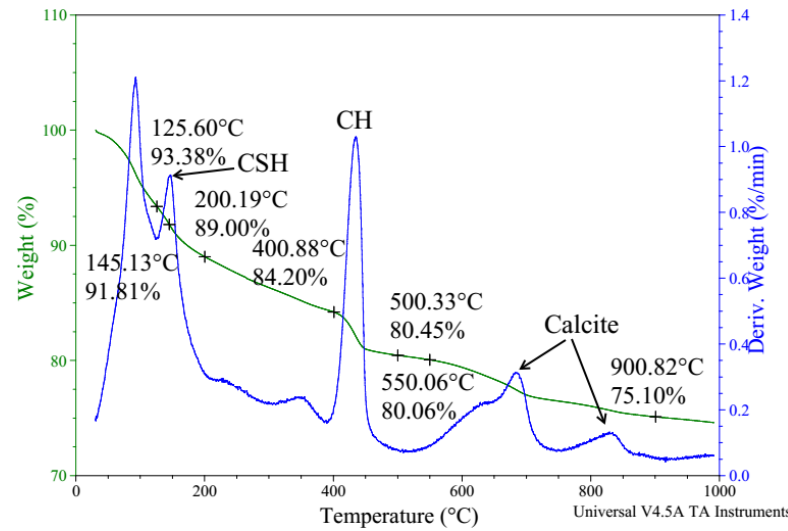
Figure 17. TGA/DTG observations of TEOS/PVP NFs-blended cement paste.